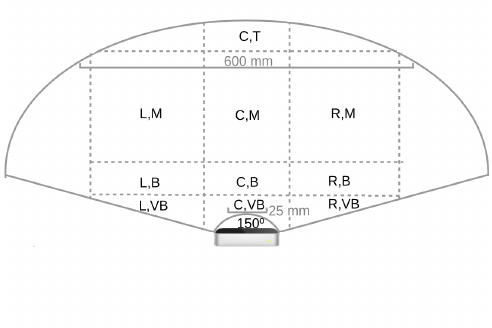
Fig. 5: Regions of gesture recognition: (C, T) = (Center, Top); (L, M) = (Left, Middle); (C, M) = (Center, Middle); (R, M) = (Right, Middle); (L, B) = (Left, Bottom); (C, B) = (Center, Bottom); (R, B) = (Right, Bottom); (L, VB) = (Left, Very Bottom); (C, VB) = (Center, Very Bottom); (R, VB) = (Right, Very Bottom).